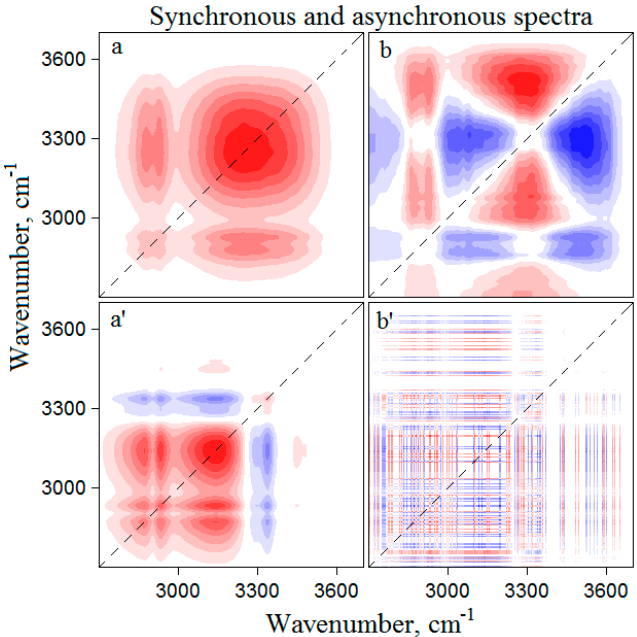
Figure 5. Experimental ( a ) synchronous and ( b ) asynchronous spectra and theoretical ( a’ ) synchronous and ( b’ ) asynchronous spectra in the 3720–2700 cm − 1 region.